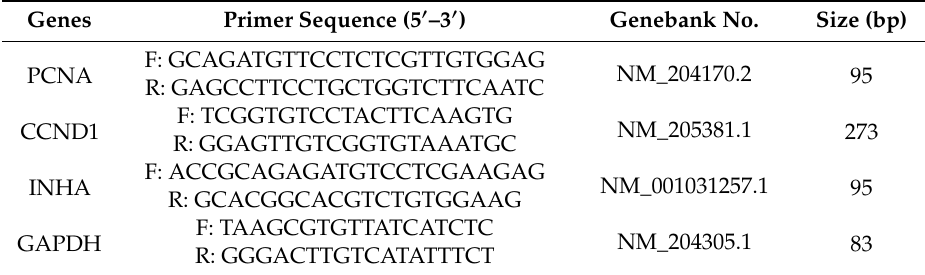
Table 3. Primer sequences for real-time quantitative